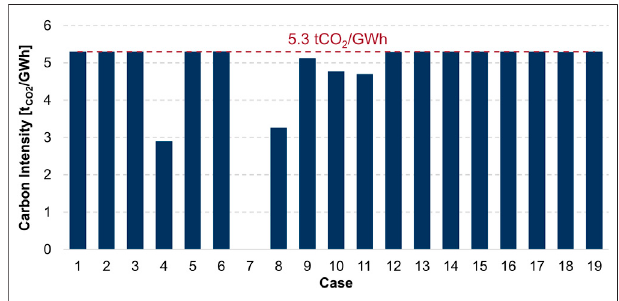
FIGURE 7 | Total electric system-wide carbon-dioxide emissions for each case FIGURE 8 | Carbon intensity and carbon intensity limit for each